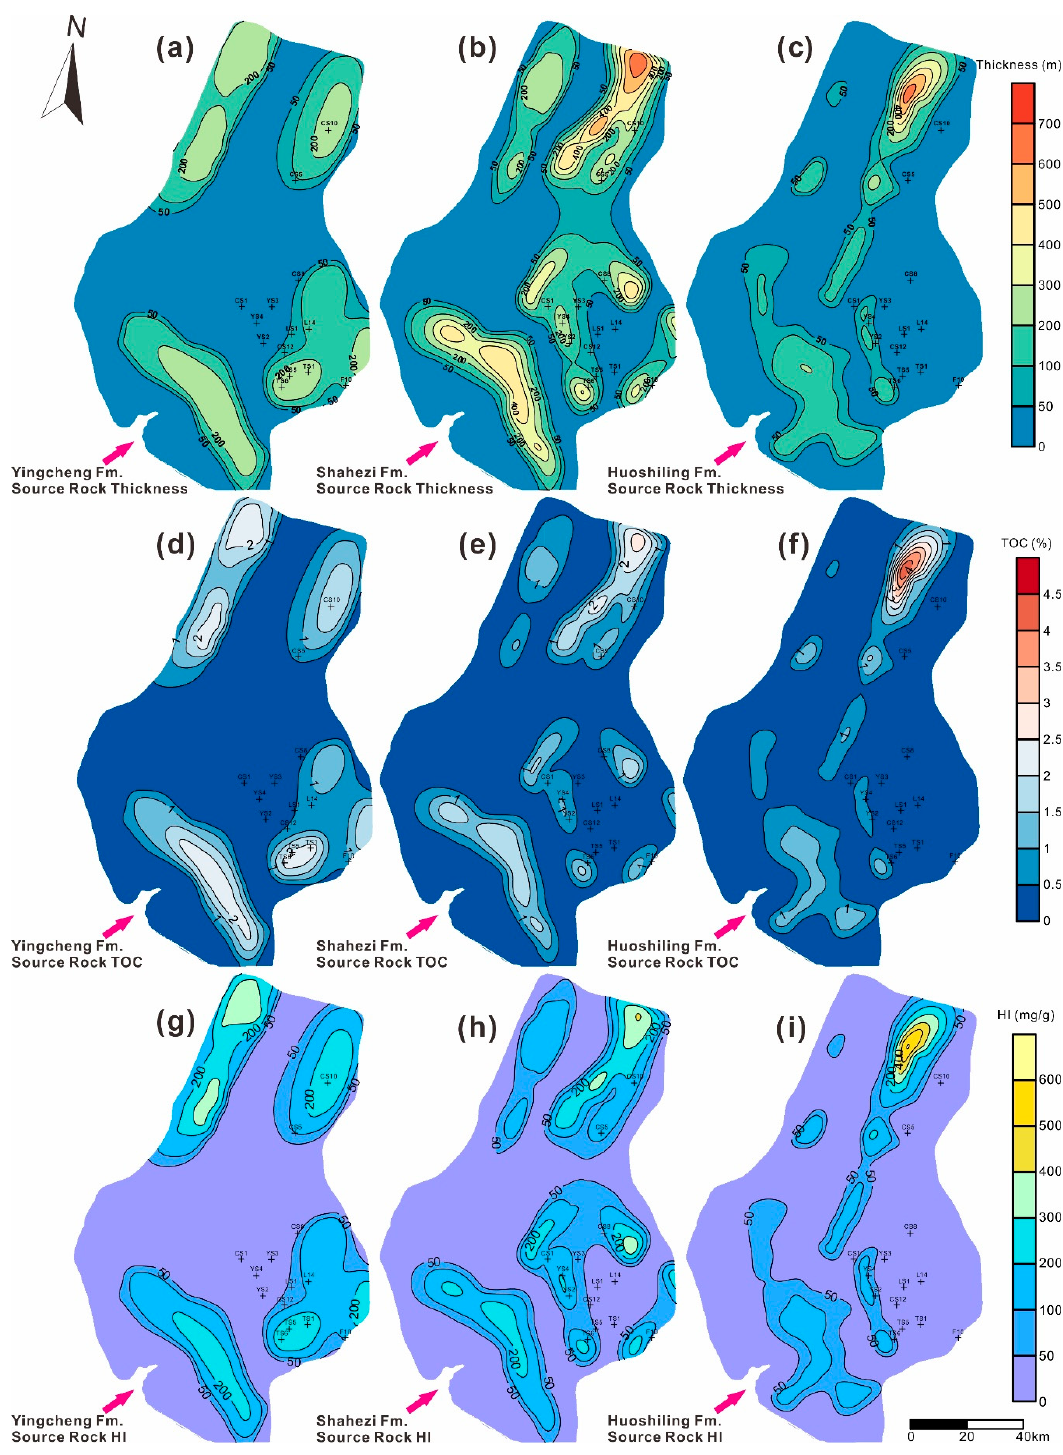
Figure 5. Maps of source rock properties. ( a ) Source rock isopach map of K 1 y. ( b ) Source rock isopach map of K 1 sh. ( c ) Source rock isopach map of J 3 h. ( d ) TOC contour map of K 1 y. ( e ) Source rock isopach map of K 1 sh. ( f ) Source rock isopach map of J 3 h. ( g ) HI contour maps of K 1 y. ( h ) HI contour maps of K 1 sh. ( i ) HI contour maps of J 3 h. (modified after literatures [15,56,64–66]).